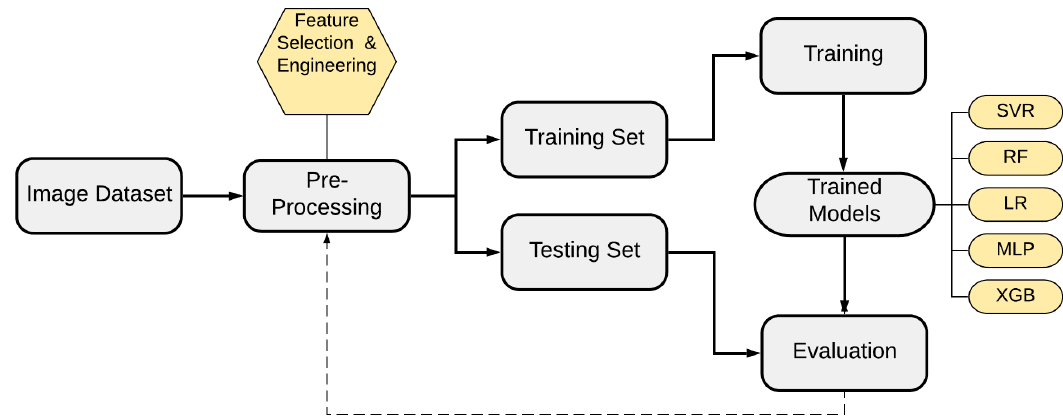
Figure 1. Flowchart showing the implementation process.